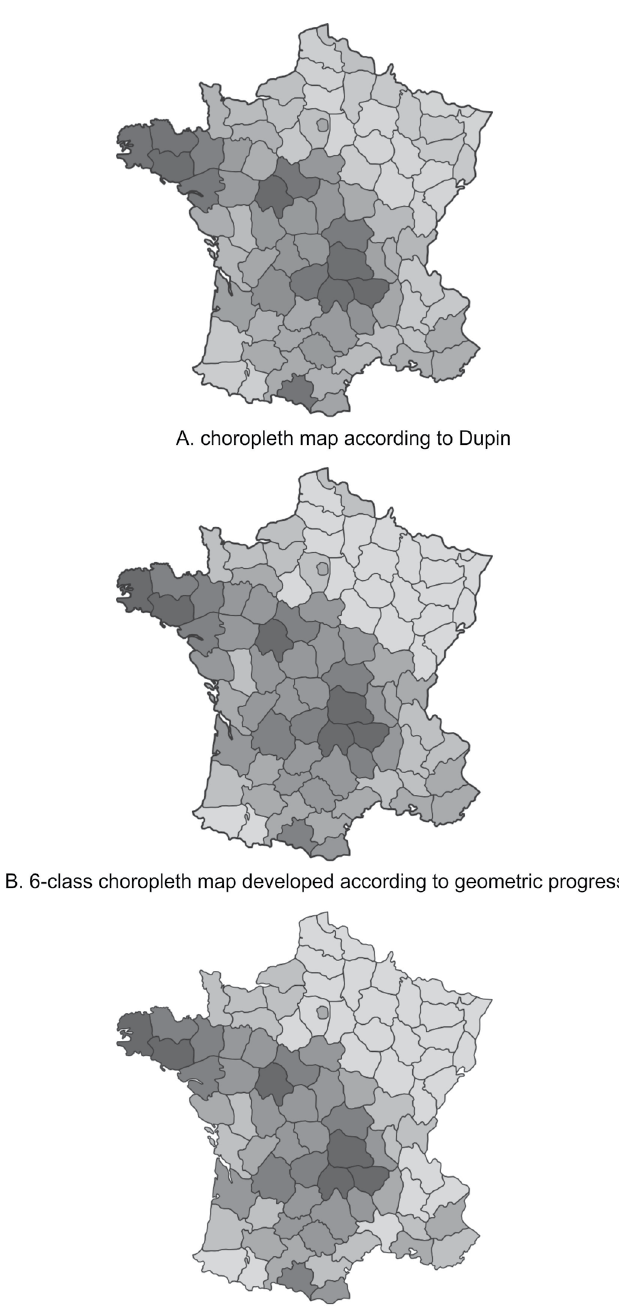
Fig. 7. Different class selection based on Ch. Dupin’s